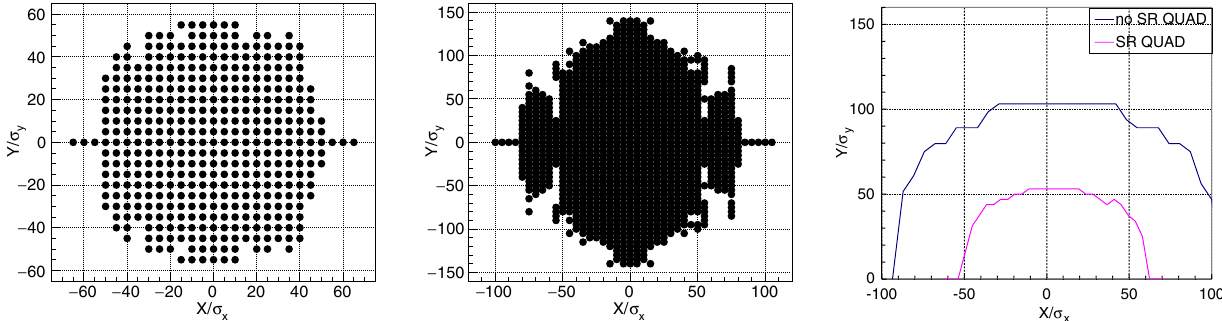
FIG. 2. Dynamic aperture: left — tracking by MADX PTC with synchrotron radiation from all magnetic elements, center — tracking by MADX PTC without synchrotron radiation from all magnetic elements, right — tracking by homemade software with synchrotron radiation from quadrupoles (blue) and without